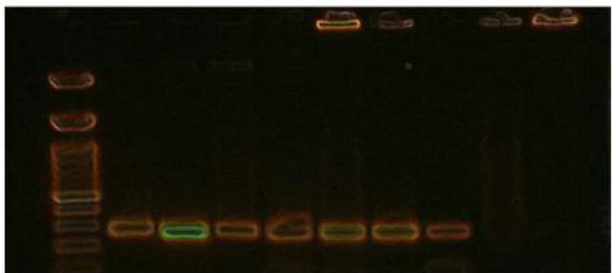
Fig. 6: Agarose gel electrophoresis showing amplification of 508 bp fragment for fim H gene of Acinetobacter species isolates. Lane 1: 1 kb Ladder, Lanes (2, 3, 4, 5, 6, 7, 8): positive for Acinetobacter species at 870bp.